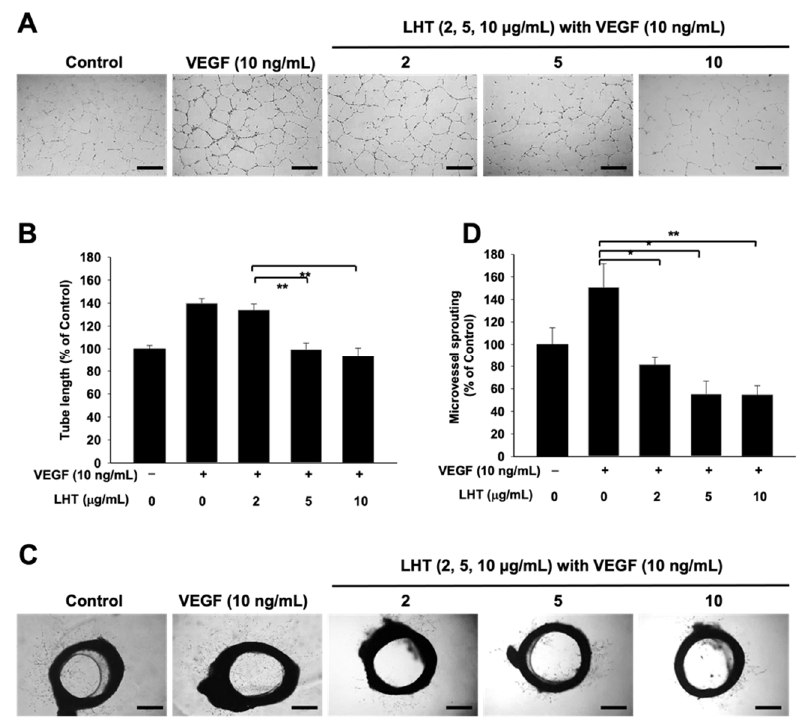
Figure 5. LHT effect on tubular formation of HUVECs in vitro. ( A ) Optical image of tubular formation of HUVECs after treatment of VEGF (10 ng/mL) or VEGF with LHT (0, 2, 5, 10 µg/mL) for 18 h. Scale bars indicate 500 µm. ( B ) Relative amount of tube lengths after treatment of VEGF (10 ng/mL) or VEGF with LHT (0, 2, 5, 10 µg/mL) for 18 h . Data were expressed with mean ± s.e.m. (n = 5). ** p < 0.01 versus the group treated with VEGF and LHT (2 µg/mL). ( C ) Optical images of new vessels sprouted from rat aortic ring after cultivation with VEGF (10 ng/mL) or VEGF with LHT (0, 2, 5, 10 µg/mL) for 6 days. Black ring: rat aorta ring. Scale bars indicate 500 µm. ( D ) Relative amount of the number of sprouting new vessels. Data were expressed with mean ± s.e.m. (n = 5). * p < 0.05 or ** p < 0.01 versus the VEGF-treated group.